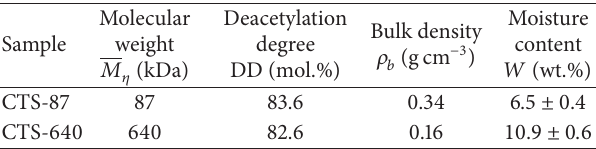
Table 1: Characteristics of powdered chitosan